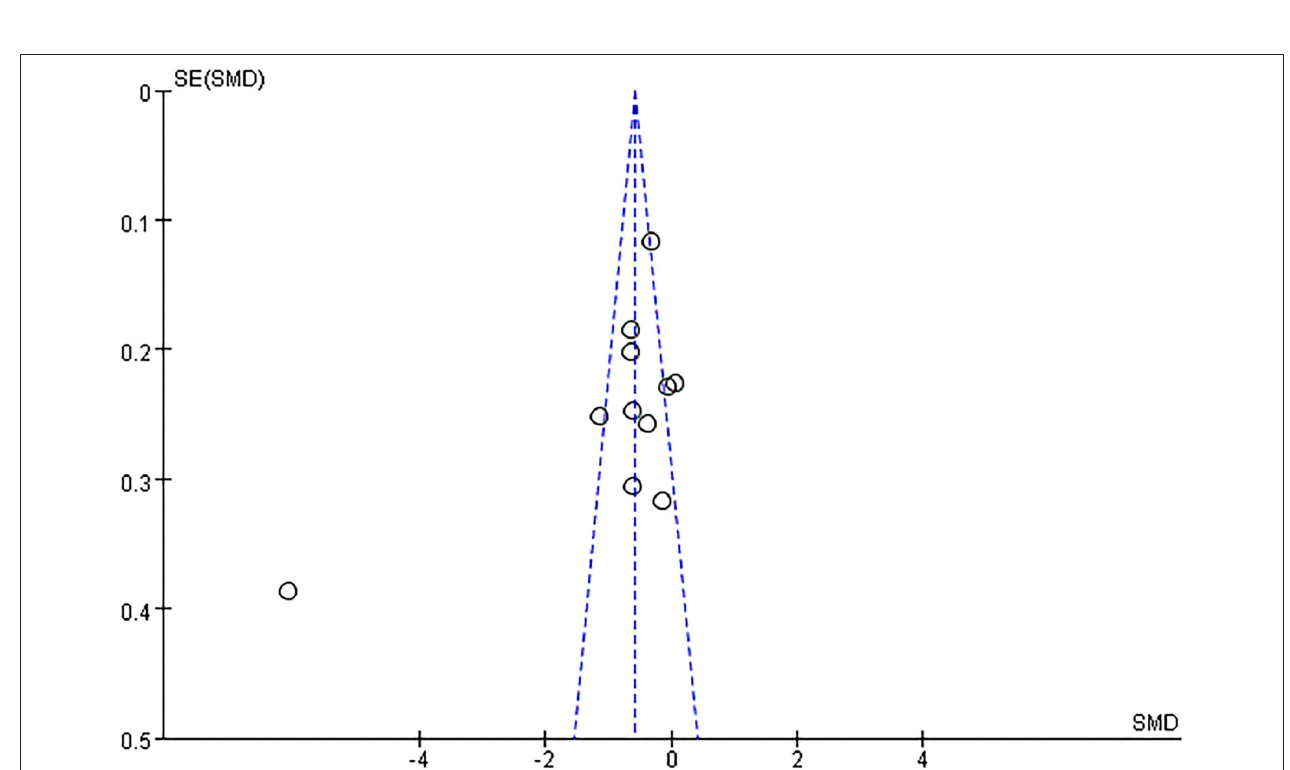
FIGURE 13 | Funnel plot on FBG of patients with